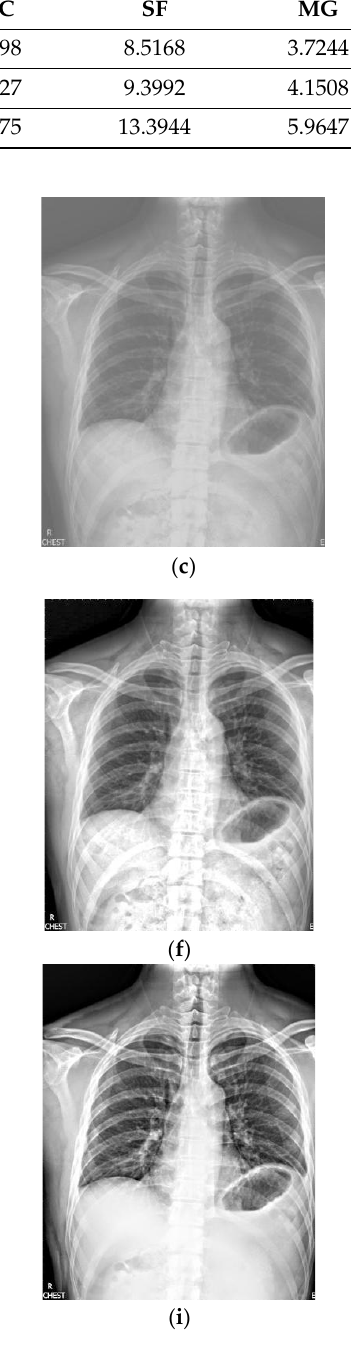
Figure 4. Comparison on X-ray image 4. ( a ) Original image; ( b ) McCann; ( c ) RLBHE; ( d ) RESIHE;